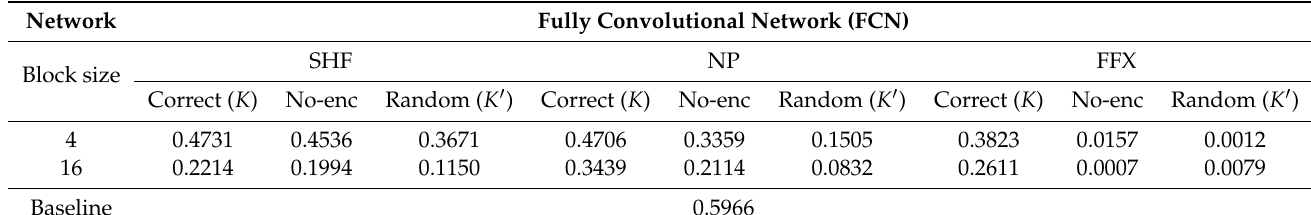
Table 2. Accuracy (mIoU) of conventional method with encrypted images [15]. Fully Convolutional Network